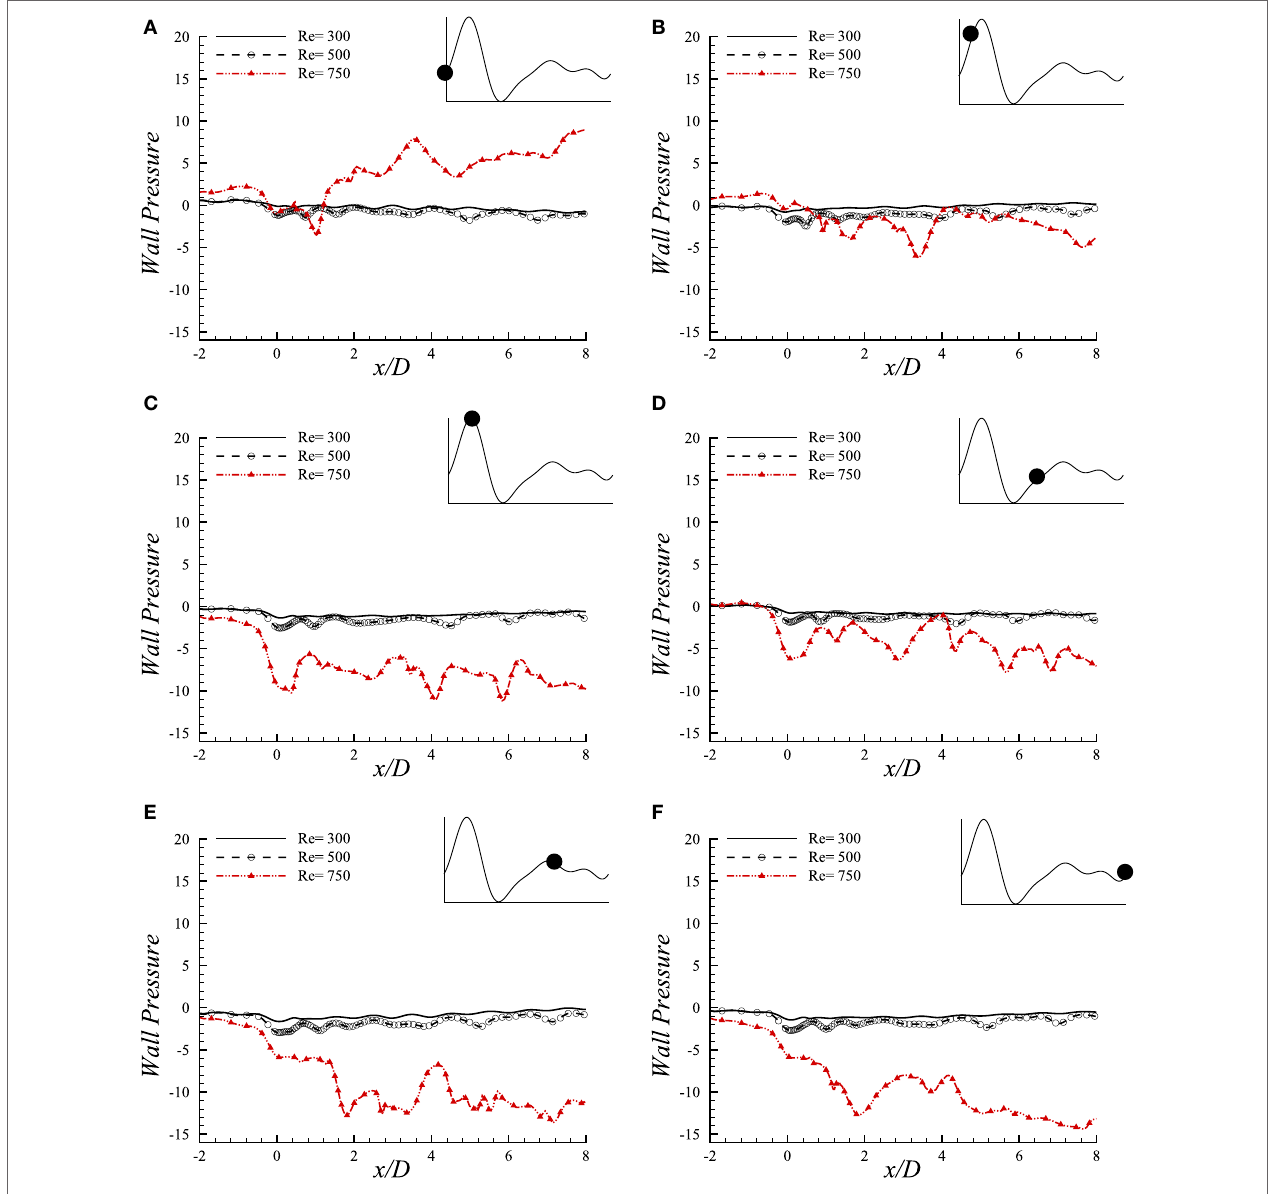
FIGURE 11 | Upper-wall pressure, p / ρ U 2 , at different physiological phases (A) t / T = 9.0, (B) t / T = 9.1, (C) t / T = 9.2, (D) t / T = 9.5, (E) t / T = 9.7, (F) t / T = 9.10 when aneurysm = 100% dilated and stenosis = 60% constricted for various Reynolds numbers, i.e., Re = 300, Re = 500, and Re = 750 where the amplitude of wall oscillation, A = 3 (cid:2) 10 (cid:0) 4